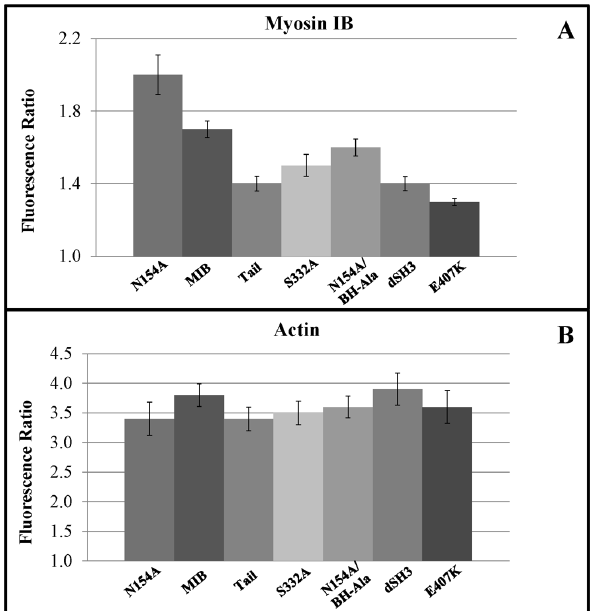
Figure 11. MIB head contributes to wave association; quanti- fication by Z-stacks. myoB 2 -cells co-transfected with mRFP-lifeact and GFP-MIB or GFP-tagged MIB mutants were starved for 30 min after which 1 m M latrunculin was added and cell images were recorded at 0.25- m m steps starting at the bottom of the cell. Panel A shows the number of optical slices in which fluorescence of MIB or its mutants were detected in the waves. Panel B shows the number of optical slices in which actin fluorescence was detected in the same waves. Between 25 and 79 images from 2–5 independent experiments were averaged for each mutant. Standard errors of means are shown. Note that actin localization continues to higher focal planes than the localization of MIB and its